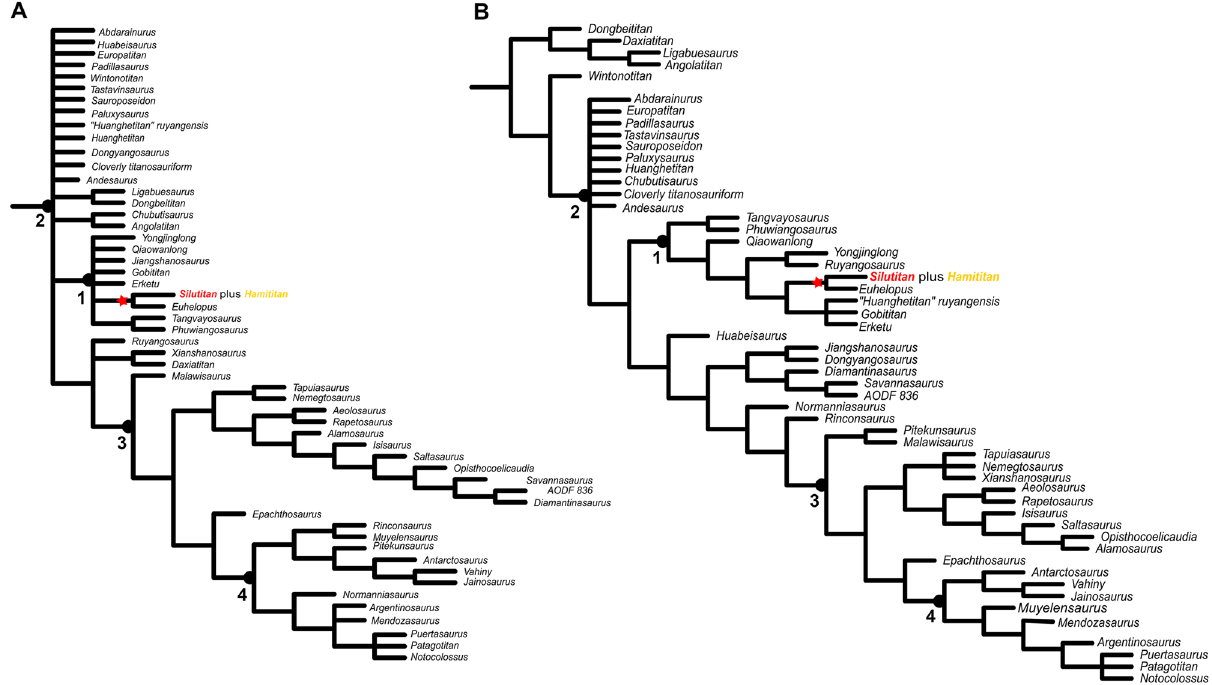
Figure 7. Strict consensus cladogram based on Mannion et al. dataset 54 , with Silutitan sinensis and Hamititan xinjiangensis scored as a single taxon: ( A ) applying equal weighting; and ( B ) applying extended implied weighting, with k-value 9. Nodes numbers indicate the clades retrieved: 1. Euhelopodidae, 2. Titanosauria, 3. Lithostrotia, and 4. Colossosauria. Silutitan sinensis is highlighted in red and Hamititan xinjiangensis , in yellow.